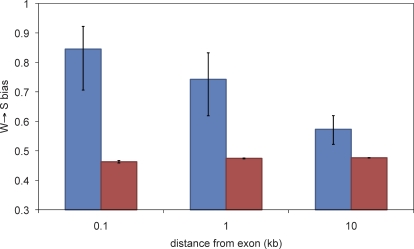
Patterns of Base Substitution in Flanking RegionsAverage W→S bias of base substitution patterns in noncoding regions surrounding the top 20 accelerated exons (blue bars) compared with W→S bias in noncoding regions surrounding all exons in the dataset (red bars). 95% confidence intervals were estimated by bootstrapping with 1,000 replicates.